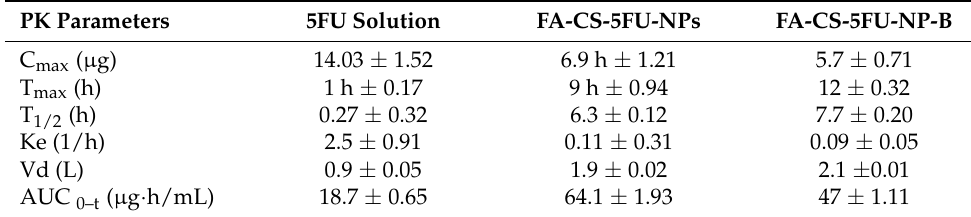
Table 3. Pharmacokinetic